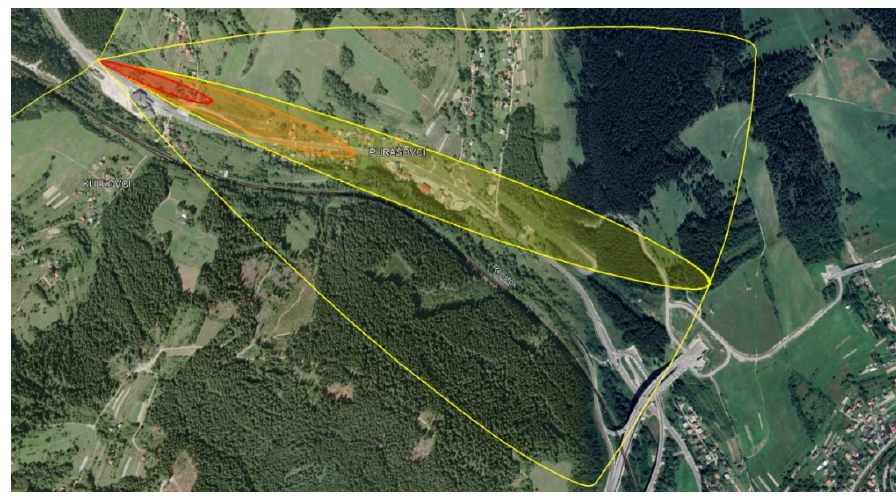
Figure 6. Graphical representation of the dispersion of a dangerous substance at the border crossing Svr č inovec-Mosty u Jablunkova [24,25].